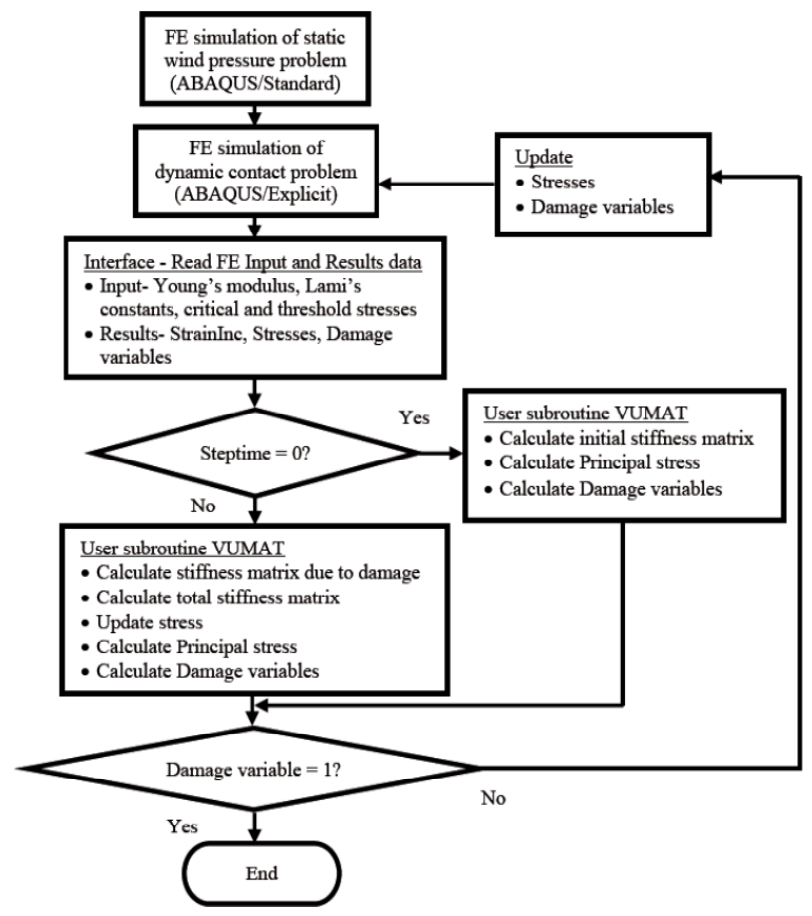
Figure 2. Flow-chart of the computational